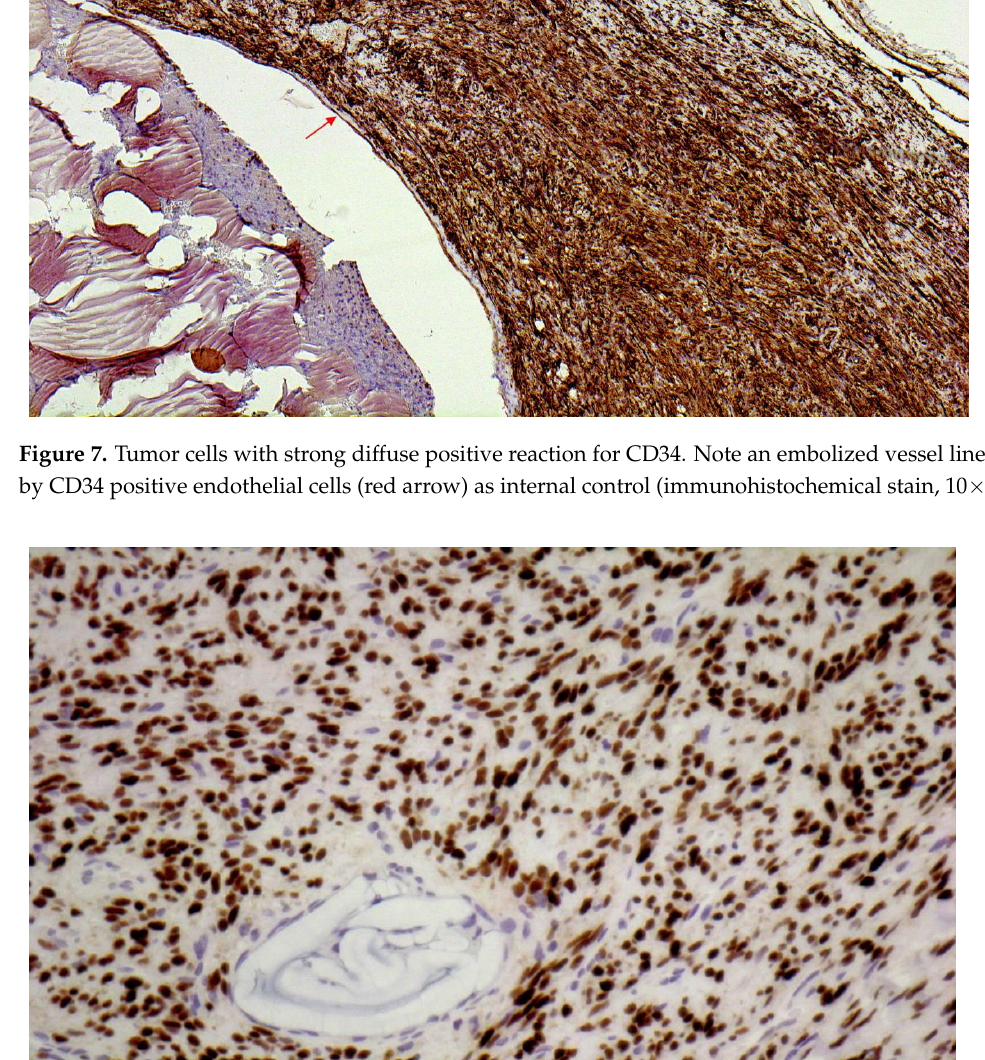
Figure 8. Strongly positive nuclear STAT6 immunohistochemical stain with adjacent vessel containing embolizing material (immunohistochemical stain, 20×).